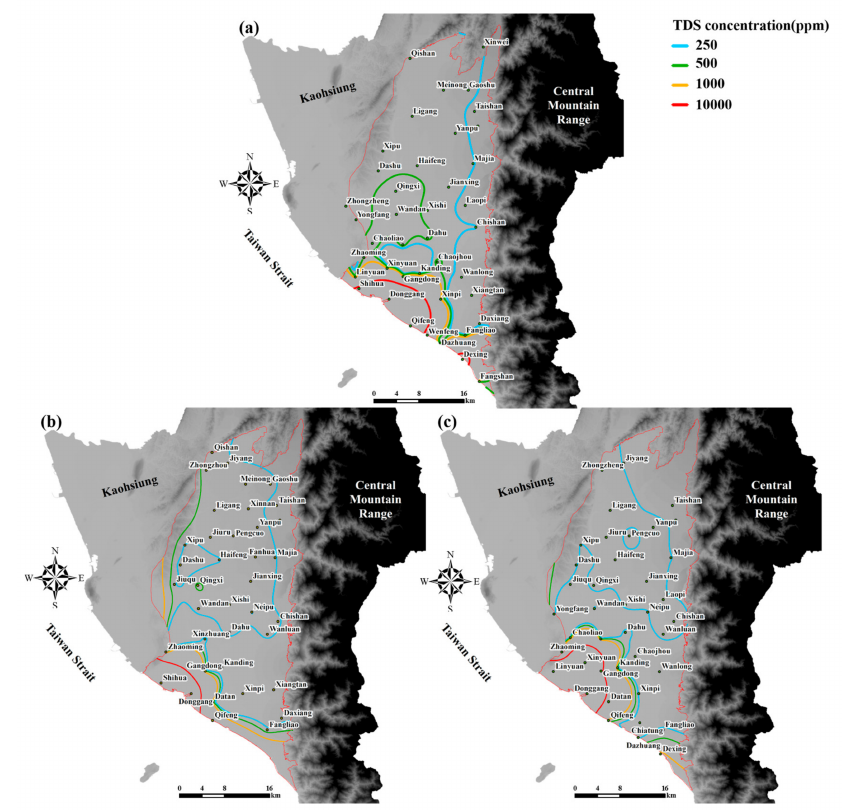
Figure 3. The concentrations of TDS in Pingtung Plain: ( a ) aquifer F1; ( b ) aquifer F2; and ( c ) aquifer